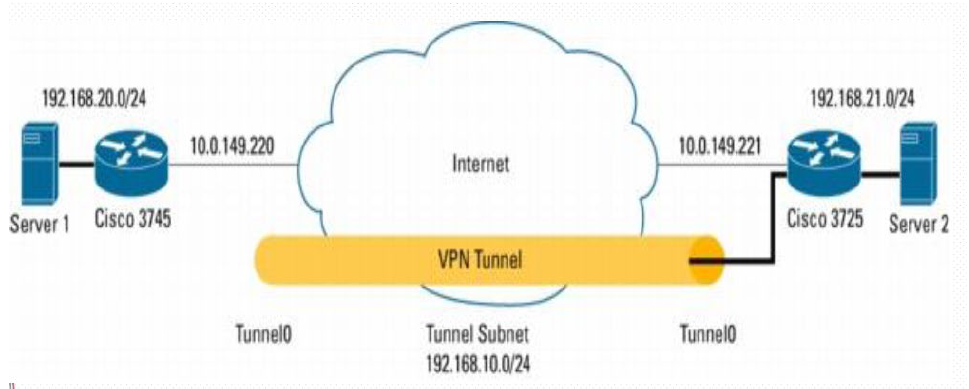
Figure 2.3. VTI Site to Site